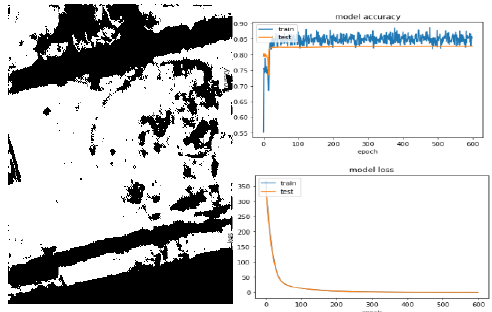
Figure 9 . Test 1 predictions: segmented image, model accuracy,